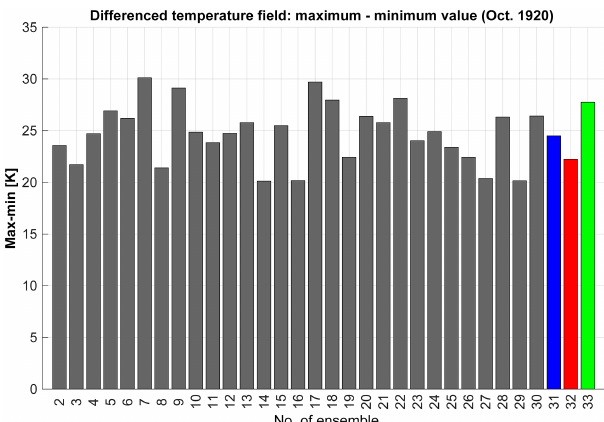
Figure 11. Difference between maximum and minimum values oc- curring in the neighbor-differences surface temperature field (TRE- FHT) for each ensemble member for October 1920. Note that mem- bers 31 and 33 have been subjected to lossy